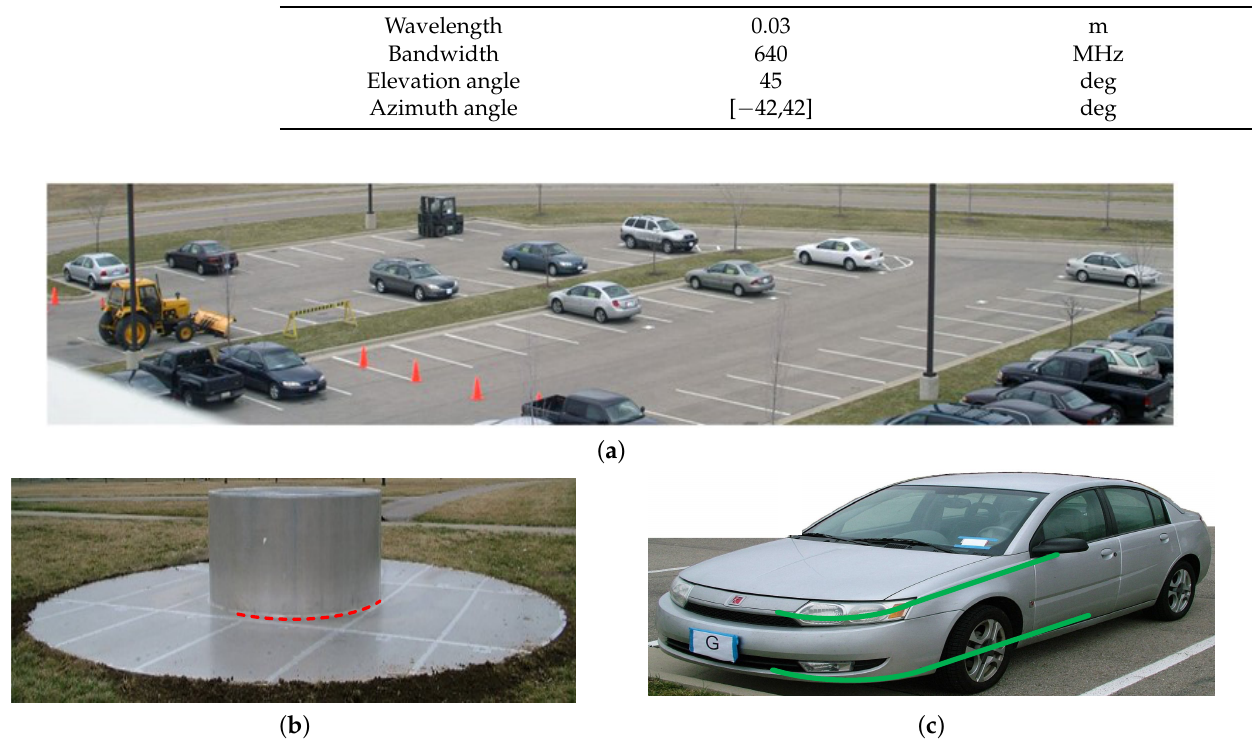
Figure 17. The illuminated scene of publicly released data: ( a ) vehicles in the scene; ( b ) the top